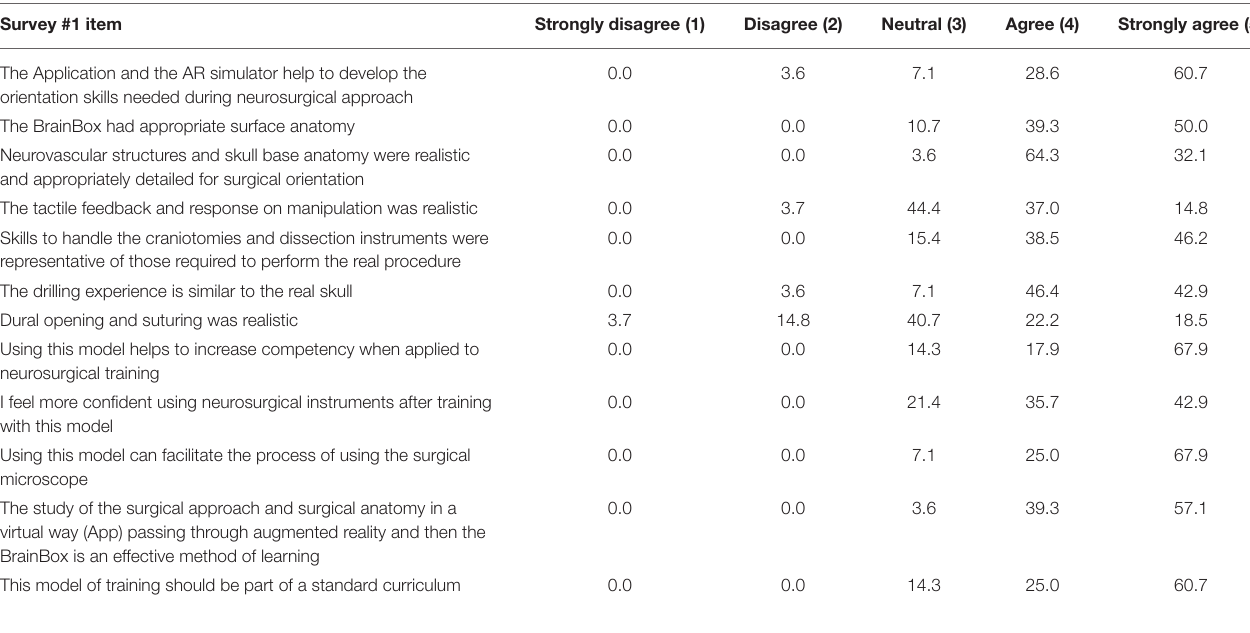
TABLE 1 | Survey results about teaching effectiveness and quality of the